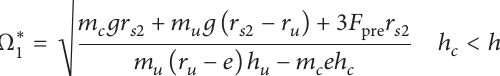
𝐽 𝐽 2 , and 3 are the three hanging joints and pretightening force applied on the joints by the spring shown in Figure 1(b). Assuming that the three joints are separated evenly along circumferential direction, distance between any two of them 𝐷 𝑠 is identical. The distance between the central axis of the assembly 𝐴 and joint 𝐽 2 can be derived as 𝑟 𝑠1 = /√3 , and the distance between 𝐴 and 𝐽 𝐷 𝑠